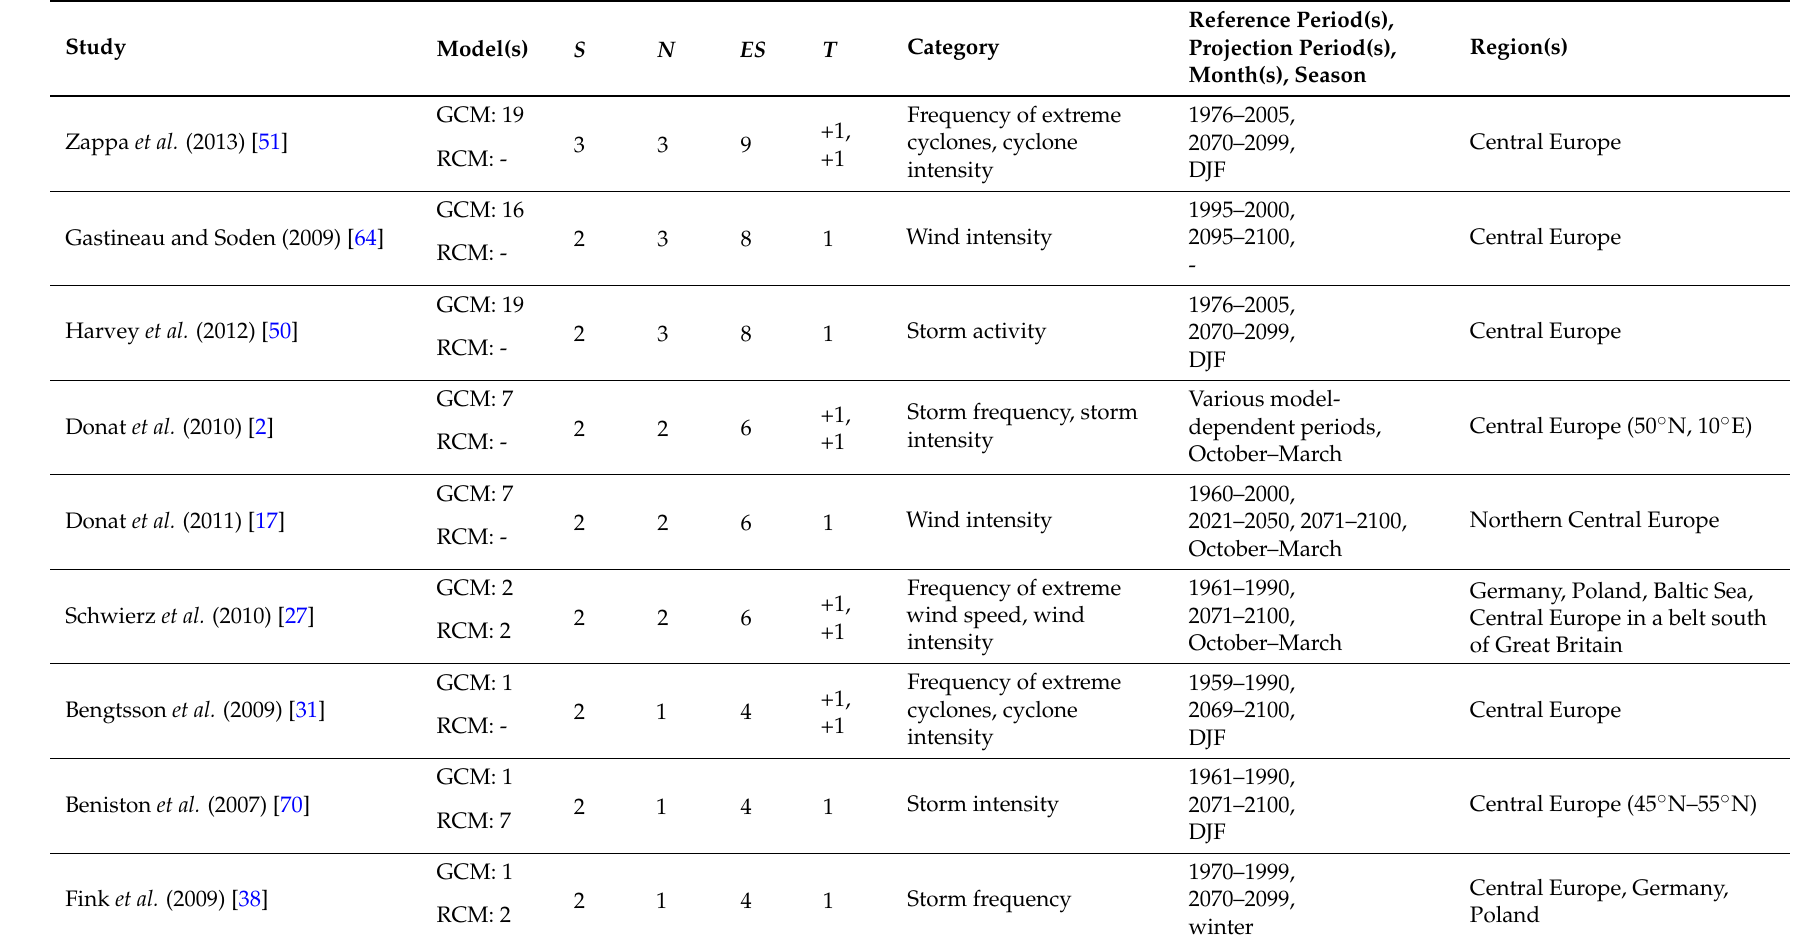
Table 4. Same as Table 1 but for the Central Europe